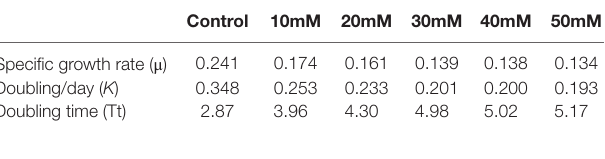
TaBle 1 | specific growth rate of S. quadricauda under different salt stress.